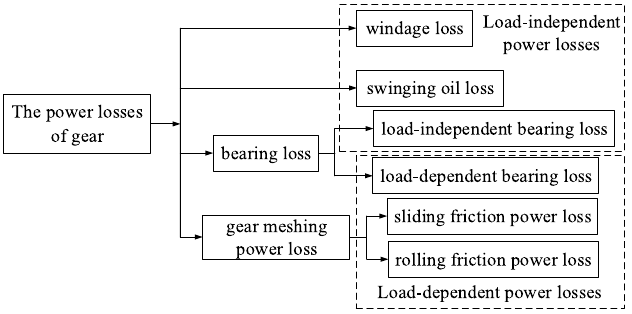
Fig. 1. The composition of power losses of gear transmission.